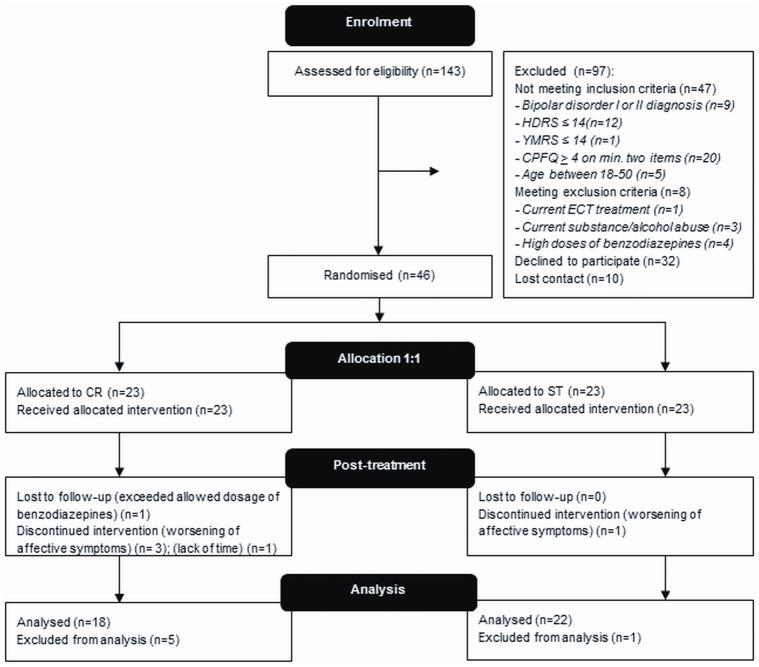
CONSORT flow-chart.